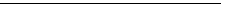
[count] for the attribute [ + individual]. Mass nouns and dual nouns as well as their syntactic context (e.g., mass noun determiners: much) lack the lexical-syntactic attribute [count]. Being unspecified for countability and individuation, mass nouns and dual nouns can inherit the lexical-syntactic and semantic specification of the syntactic context (e.g., the count noun determiner “a” assigns its [count] specification to the dual noun “chicken” and leads to a count reading of and a semantic interpretation of “chicken” as individuated